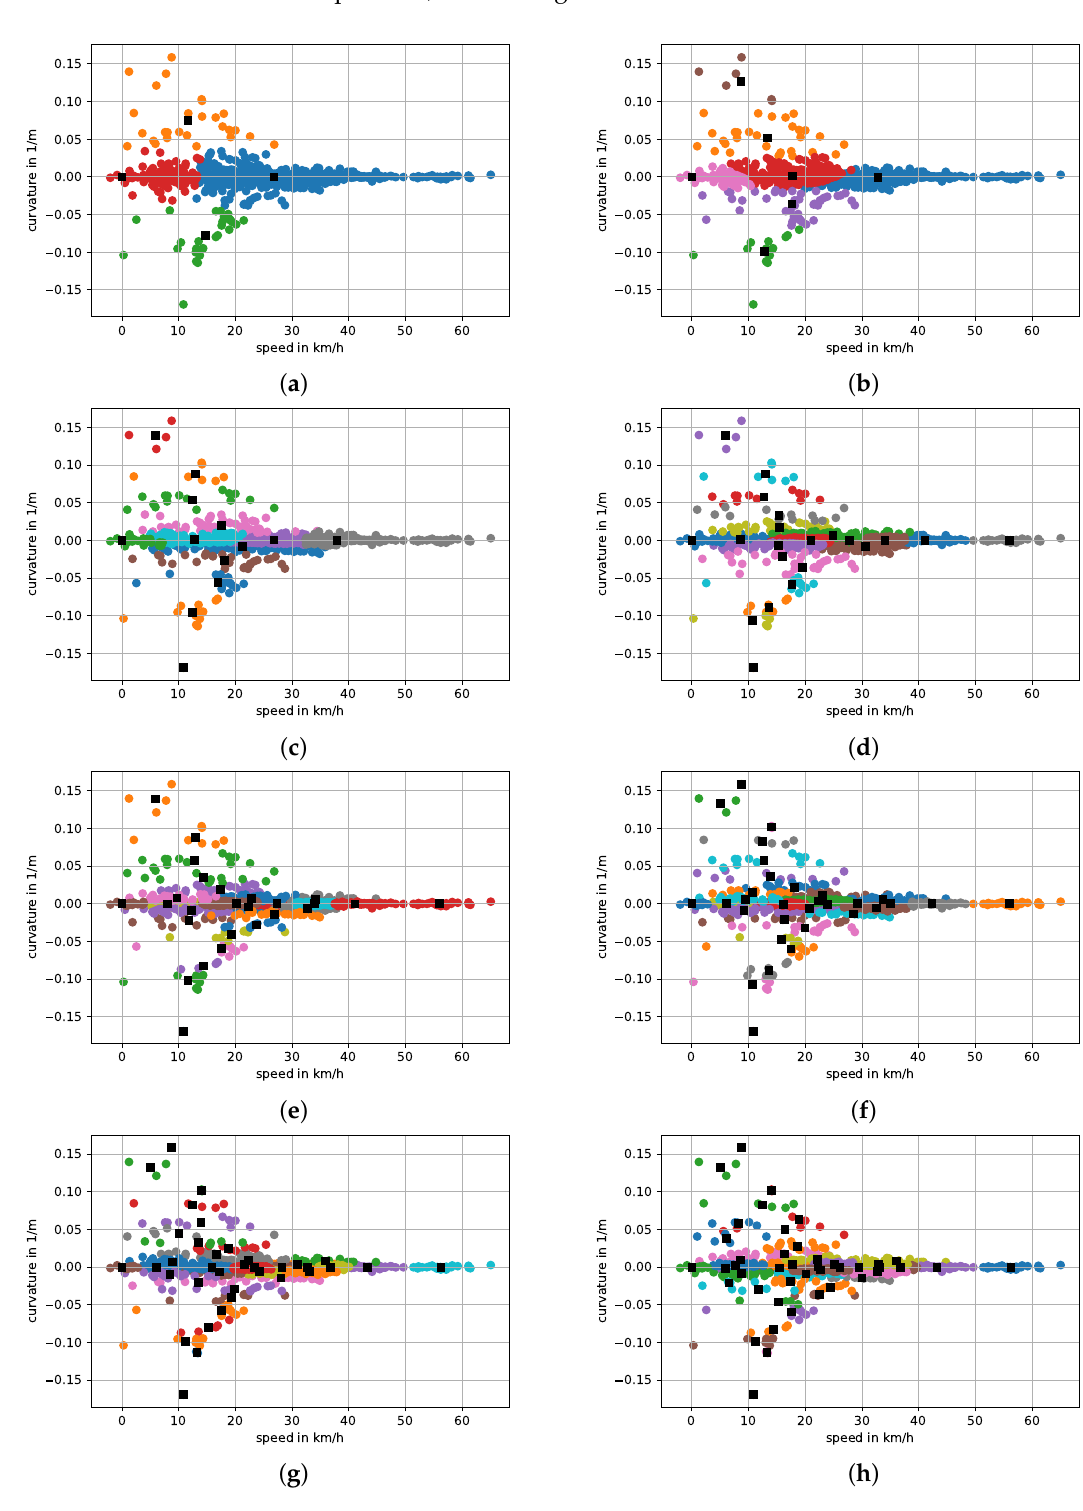
Figure 5. Automata with clustered trims using k-means, where the black squares are the centers of each cluster: ( a ) 4 trims; ( b ) 7 trims; ( c ) 13 trims; ( d ) 21 trims; ( e ) 26 trims; ( f ) 31 trims; ( g ) 36 trims; ( h ) 43